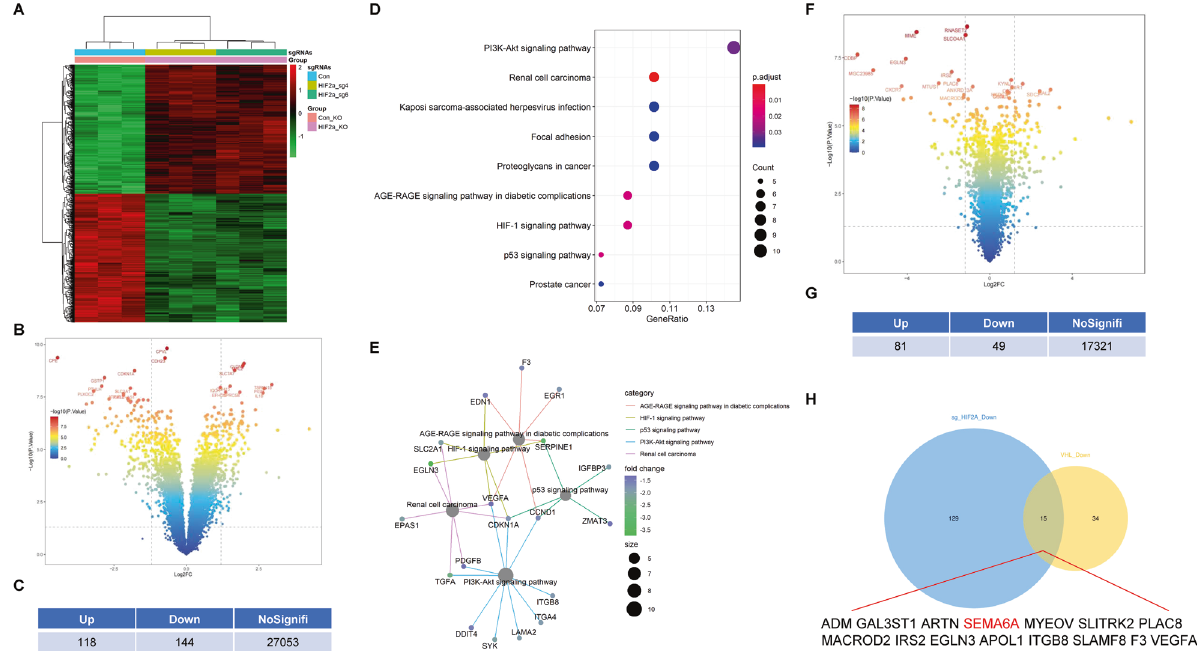
Fig. 1 Identi fi cation of the potential target genes of the VHL - HIF-2 α axis in ccRCC cells. A Heatmap of the DEGs expression regulated by HIF-2 α in ccRCC cells in GSE149005. p < 0.05, | log2FC| > 1.2. B Volcano map of DEGs expression regulated by HIF-2 α in GSE149005. C Number of up- and downregulated DEGs in GSE149005. D KEGG pathway analysis of the downregulated genes in GSE149005 through the clusterPro fi ler R package. E Gene network diagram generated by the clusterPro fi ler R package showed the key genes associated with the enrichment pathway. F Volcano map of the DEGs in GSE32297. p < 0.05, |log2FC| > 1.2. G Number of up- and downregulated DEGs in GSE32297. H Venn diagram shows the intersection between the downregulated genes in GSE149005 and GSE32297